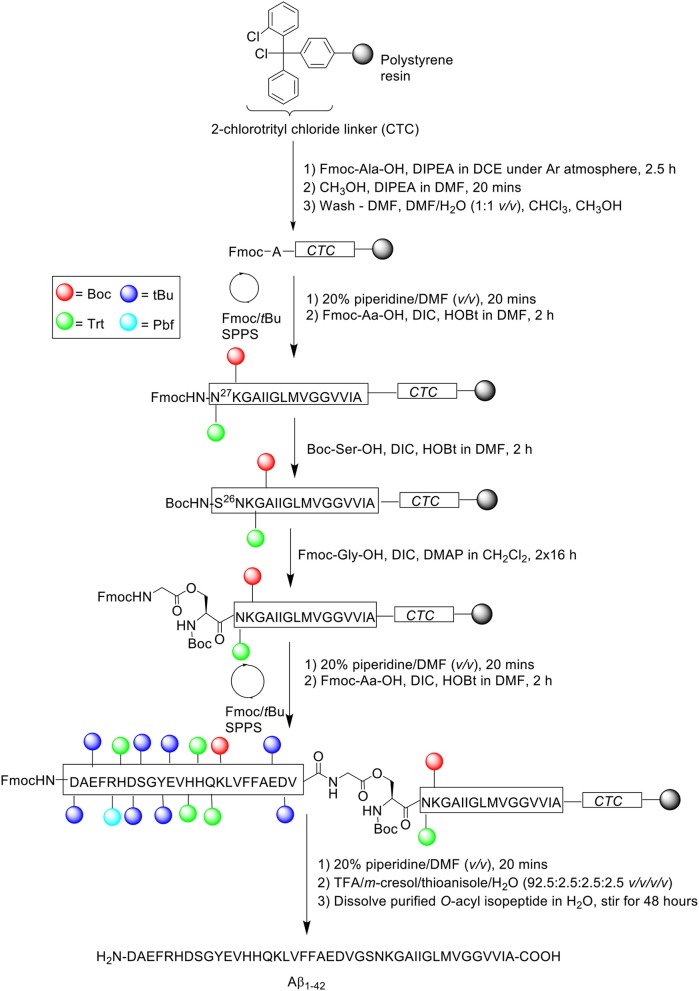
Fmoc/tBu SPPS of '26-O-acyl-isoAβ1−42' by Sohma et al. (2005).